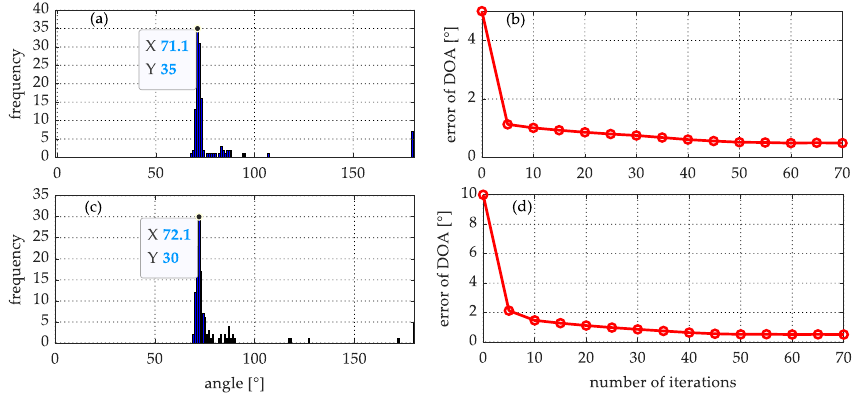
Figure 5. Histograms and DOA errors of the target source. (a) Histogram and (b) DOA error of the target source when the error of the initial DOA was 5°; (c) histogram and (d) DOA error of the target source when the error of the initial DOA was